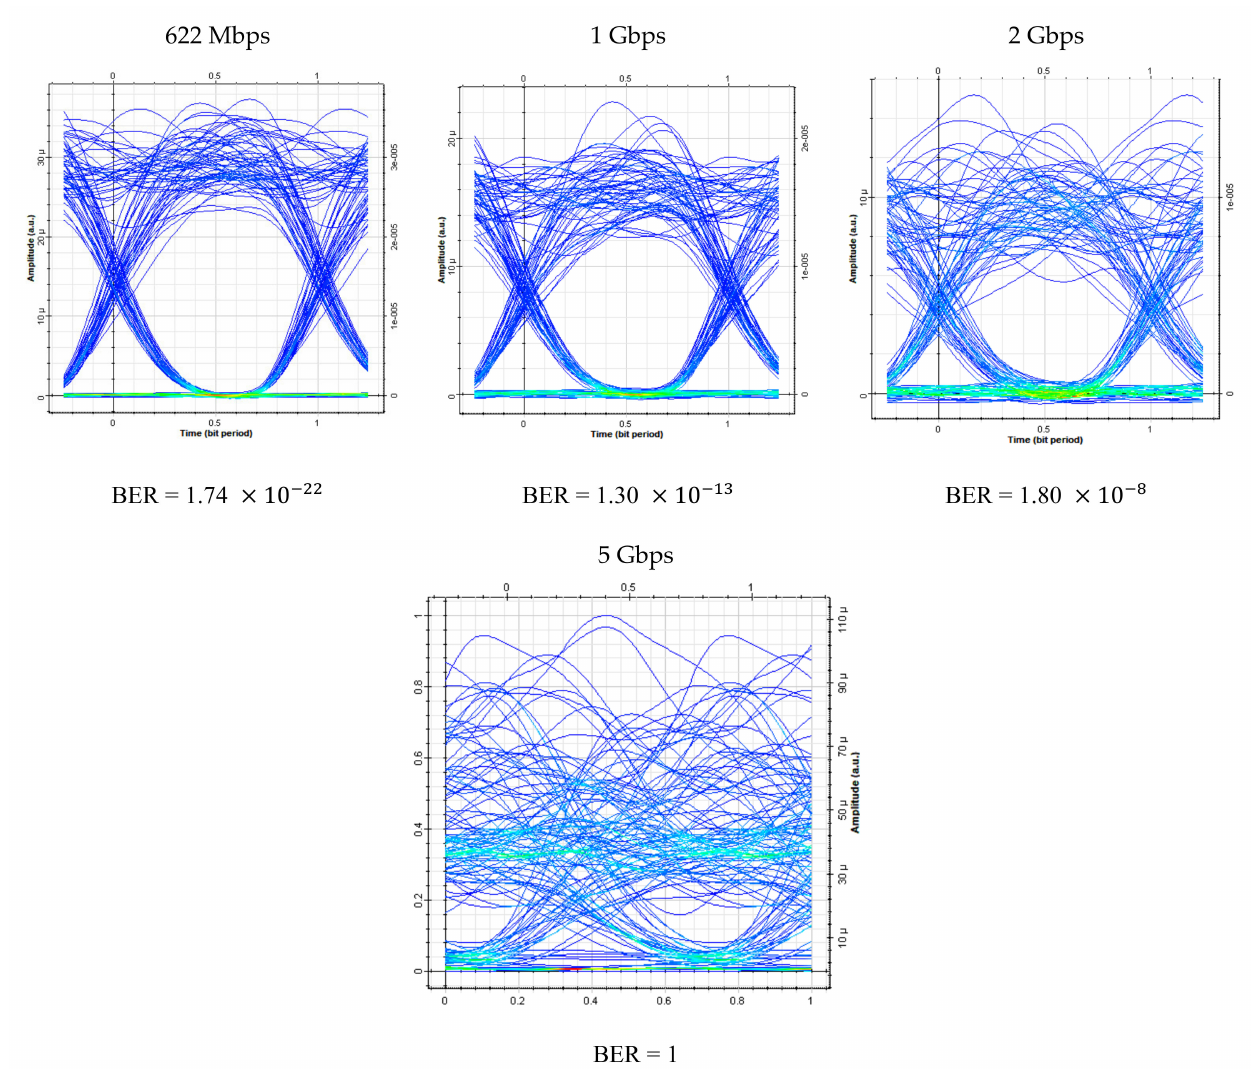
Figure 9. Eye diagram for one user at 10 km and different bit rates.